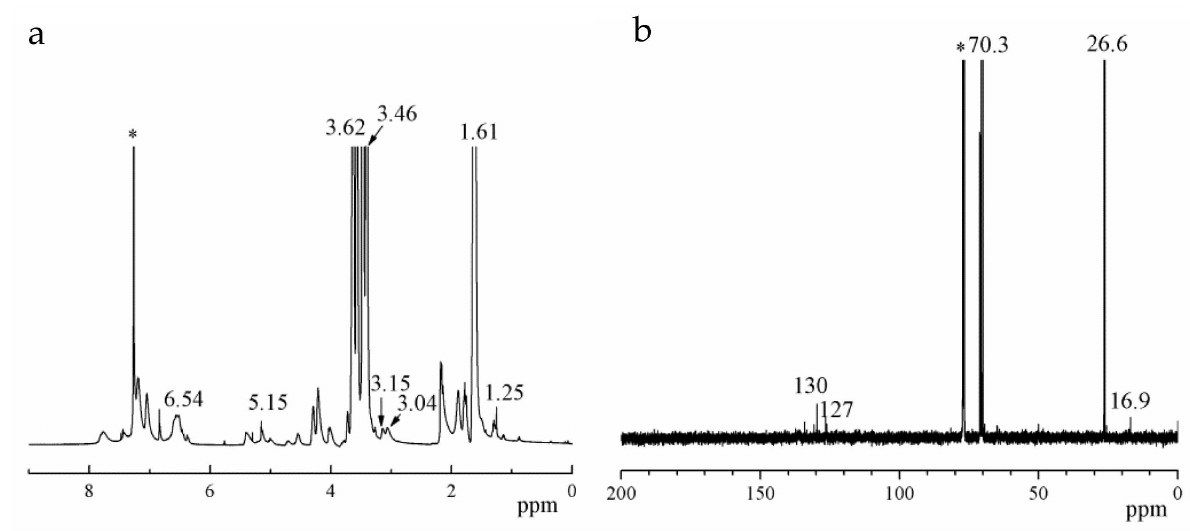
Figure 2. 1 H NMR ( a ) and 13 C NMR ( b ) spectra of PET-DA-PU. (‘*’ for CDCl 3